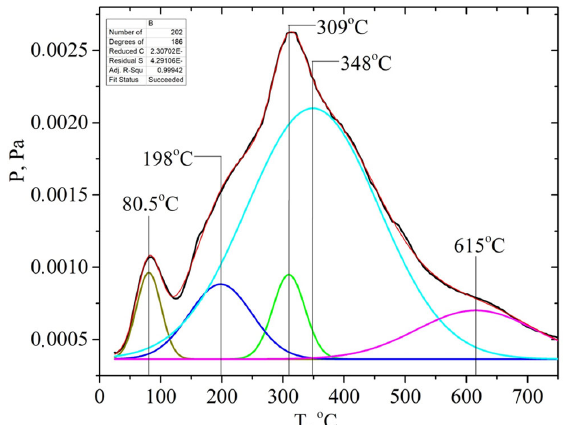
Figure 9. Deconvolution of the P/T curve for the solid based on apricot seed shells after alkaline pretreatment into separate Gaussians. Cellulose: apricot seed shell ; walnut shell ; hemicellulose: apricot seed shell ; walnut shell . In addition, the ion with m/z 60 ([H 2 C=C(OH) 2 ] + ) is the most intense one in the mass spectrum of acetic acid. Hemicellulose pyrolysis is accompanied